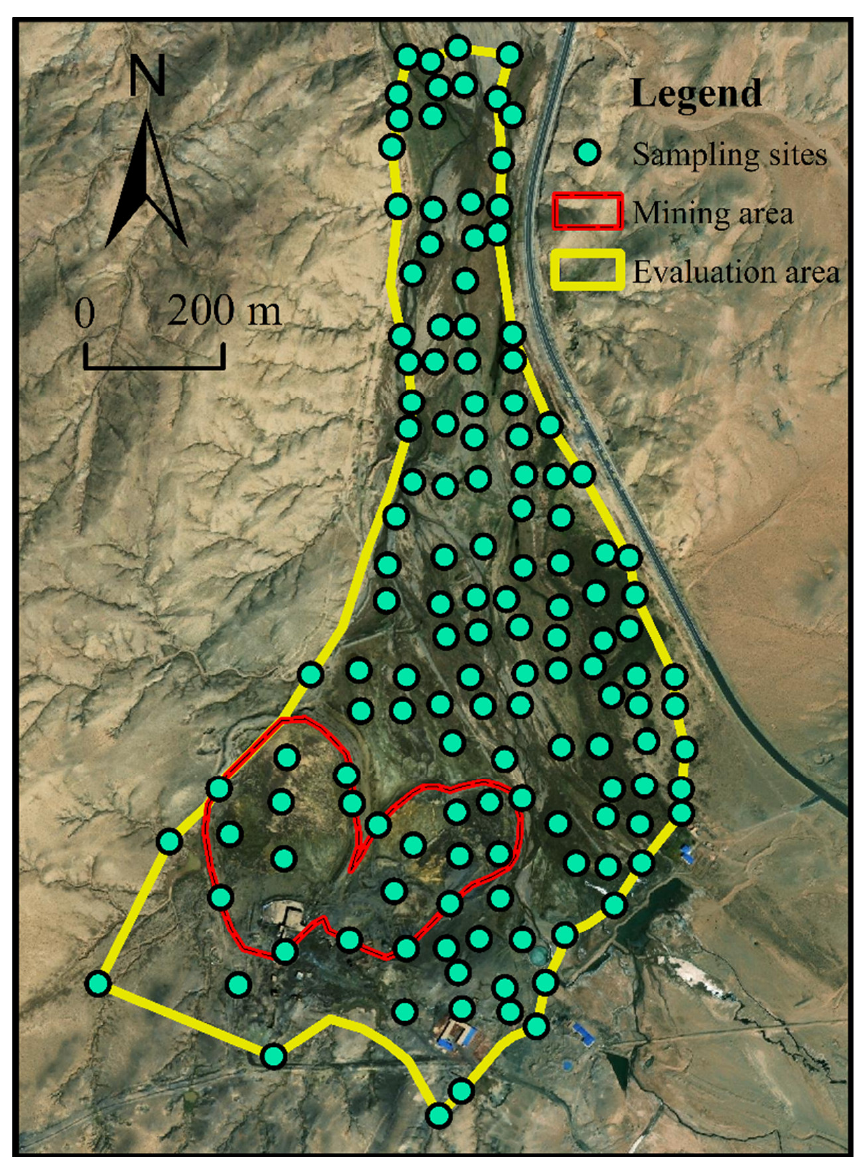
Figure 1. Soil sampling sites in the evaluation area.